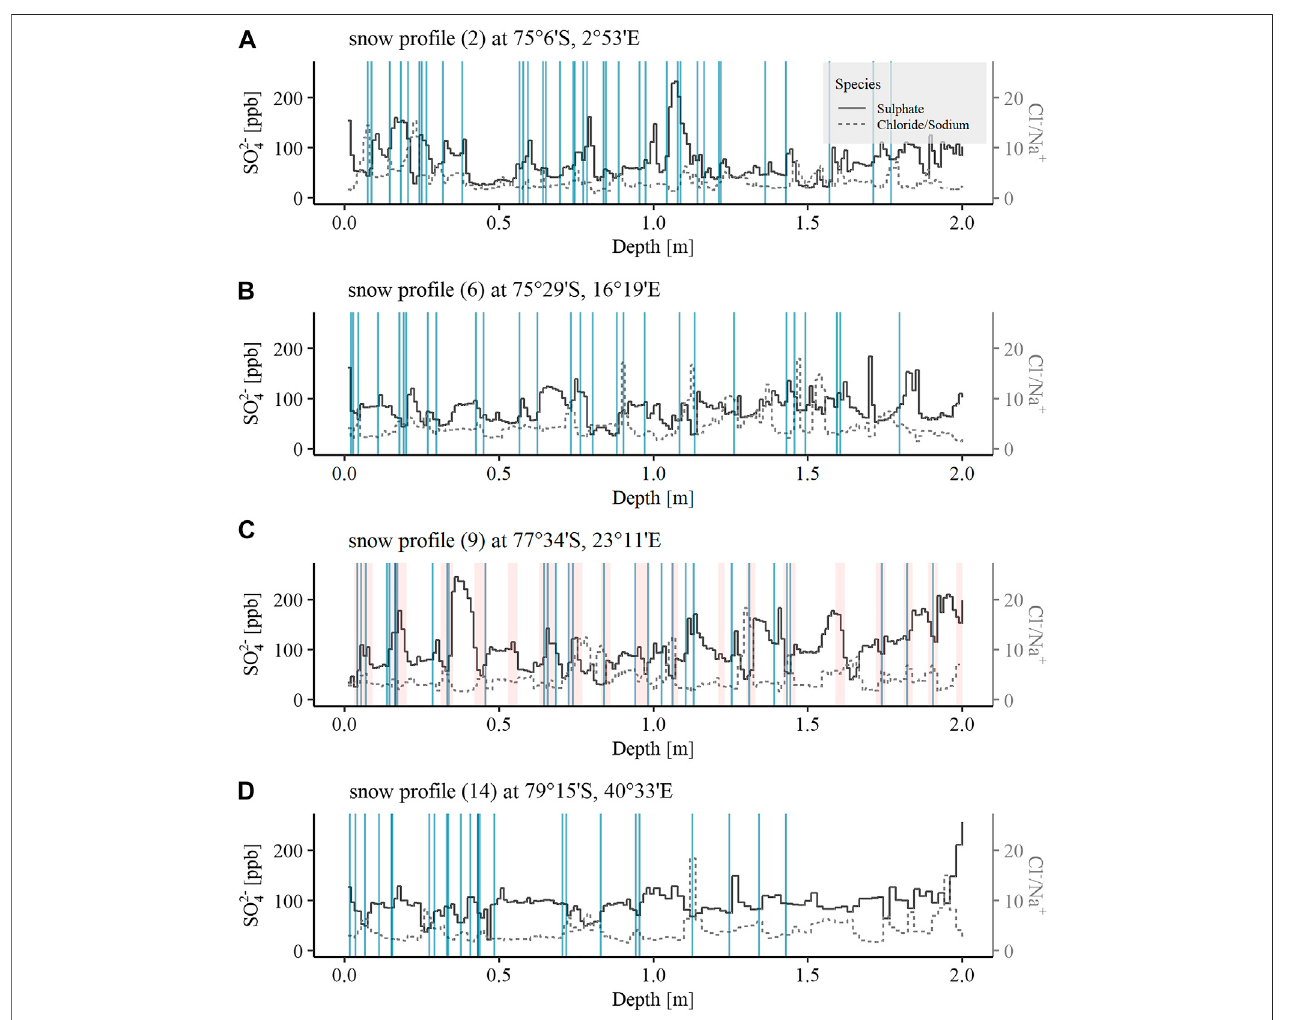
FIGURE10| Fourexemplarypro fi lesofSO 42 − (blackline),Cl − /Na + (graydottedline)andcrusts(blueverticallines).Allionpro fi leshavea1 cmresolution.Apossible dating version of pro fi le 9 shows summer intervals in shaded red vertical bars. Corresponding locations can be found in Figure 1 .